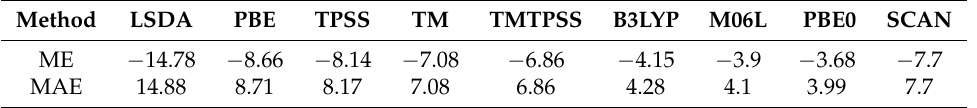
Table 3. Summary of deviations of the calculated reaction barrier heights from best values [41] for the BH76 test set. Results are taken from Reference [42] for M06L, Reference [8] for SCAN, and Reference [41] for local spin-density approximation (LSDA), PBE, TPSS, B3LYP, and PBE0. All values are in kcal/mol. ME = theory − best values from Reference